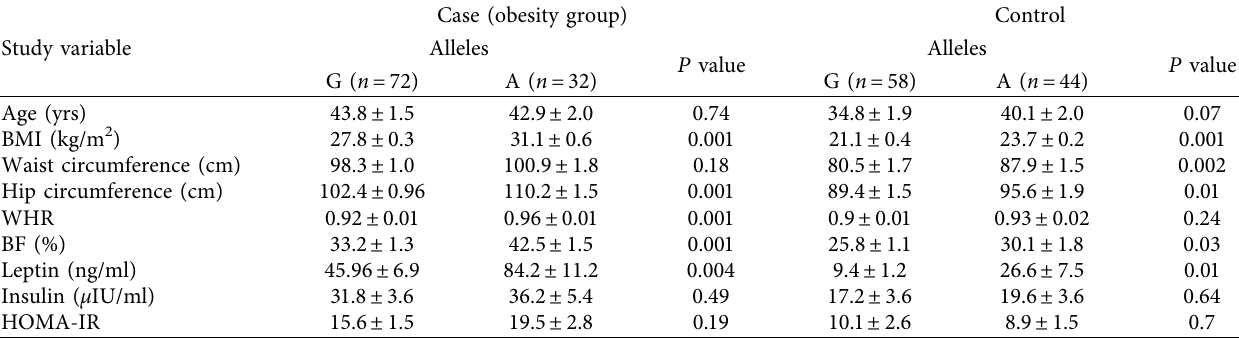
Table 4: LEP +19G/A alleles and selected study